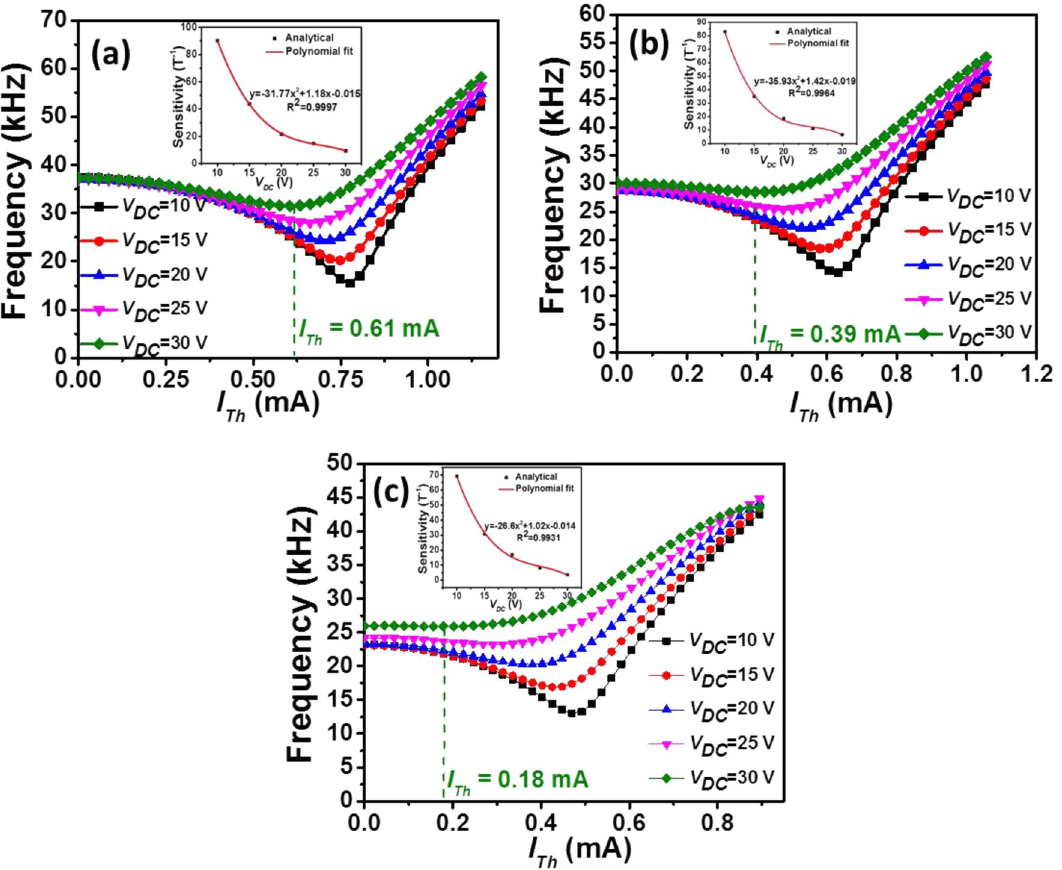
Figure 7. The simulated variation of the resonance frequency versus I Th for various values of V DC and different micro-beam’s length L ( a ) L = 700 μm, ( b ) L = 800 μm, and ( c ) L = 900 μm. The insets show the corresponding S versus voltage V DC